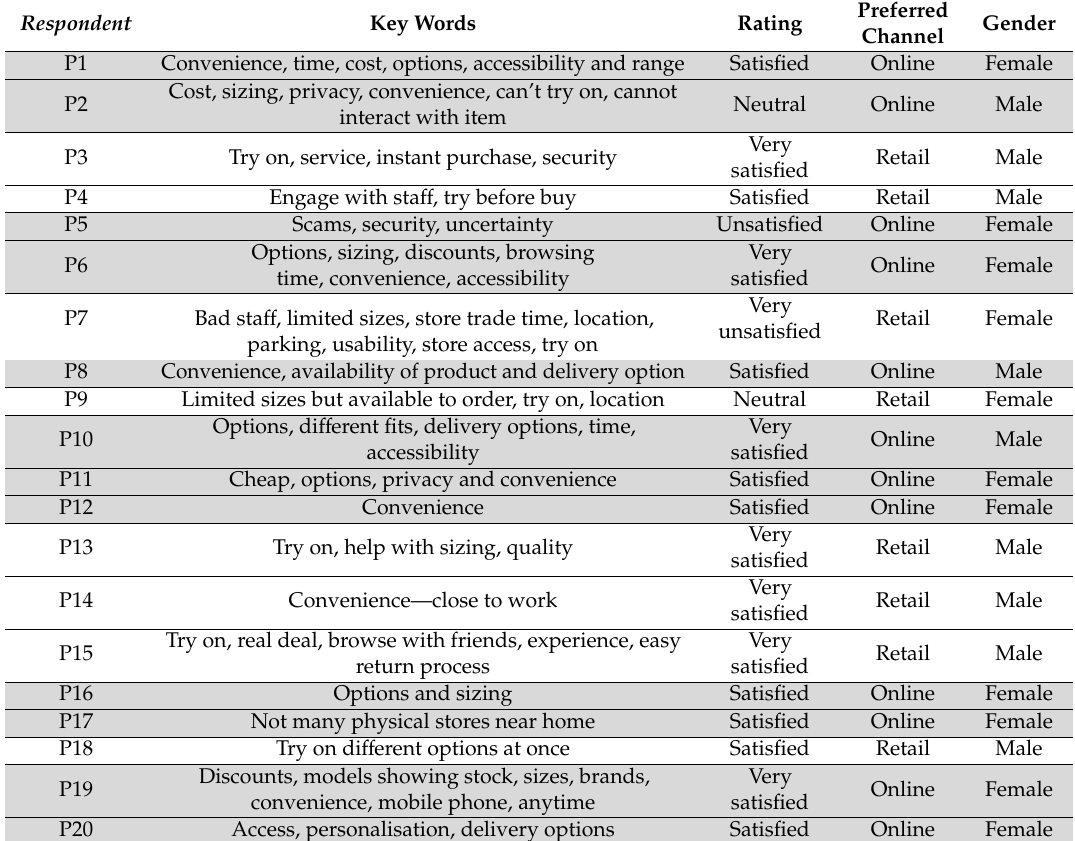
Table 3. Key words from Question